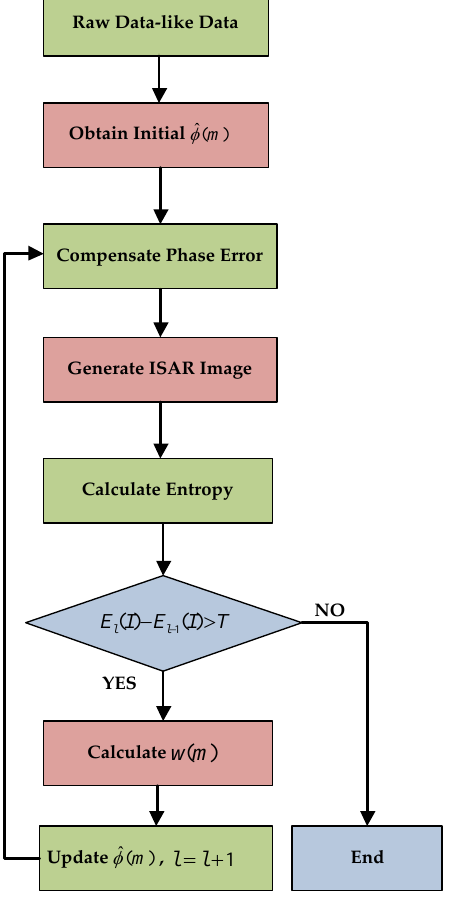
Figure 4. The basic flowchart of phase compensation method based on fast minimum-entropy.